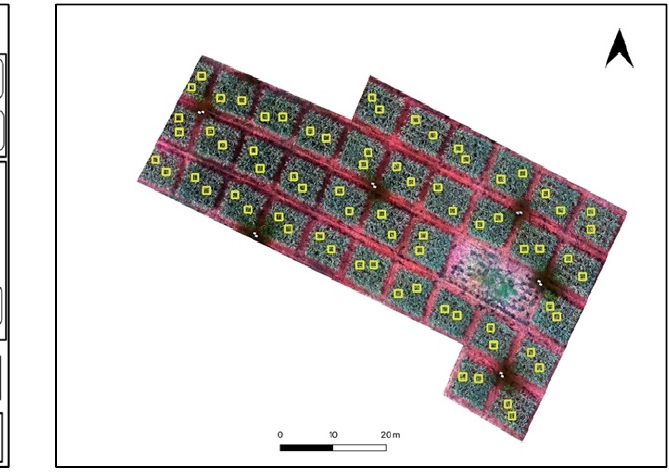
Figure 2. Experimental design. Table 3. Different fertilizer applications.